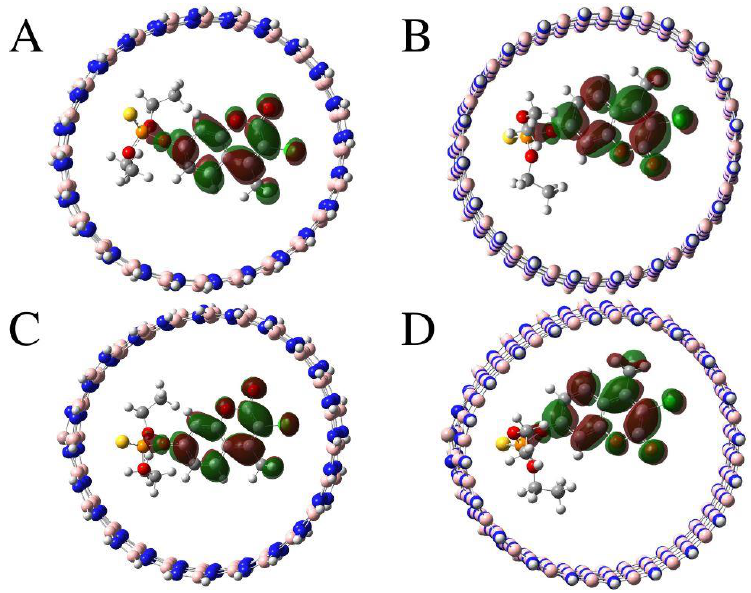
Figure 9. The LUMO diagrams of ( A ) BNNT(12,12) + cou, ( B ) BNNT(20,0) + cou, ( C ) Al-BNNT(12,12) + cou, and ( D ) Al-BNNT(20,0) + cou.